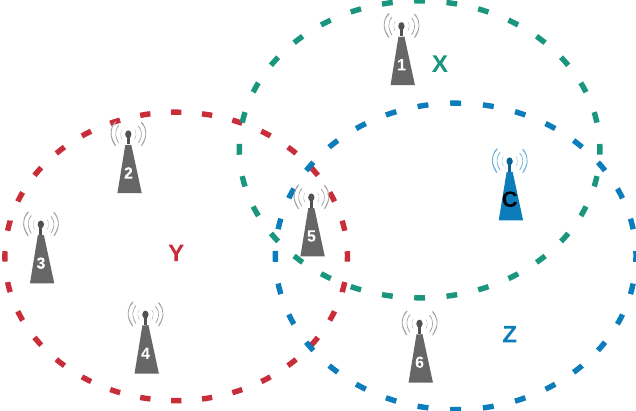
Figure 1. Wireless sensor network that needs a